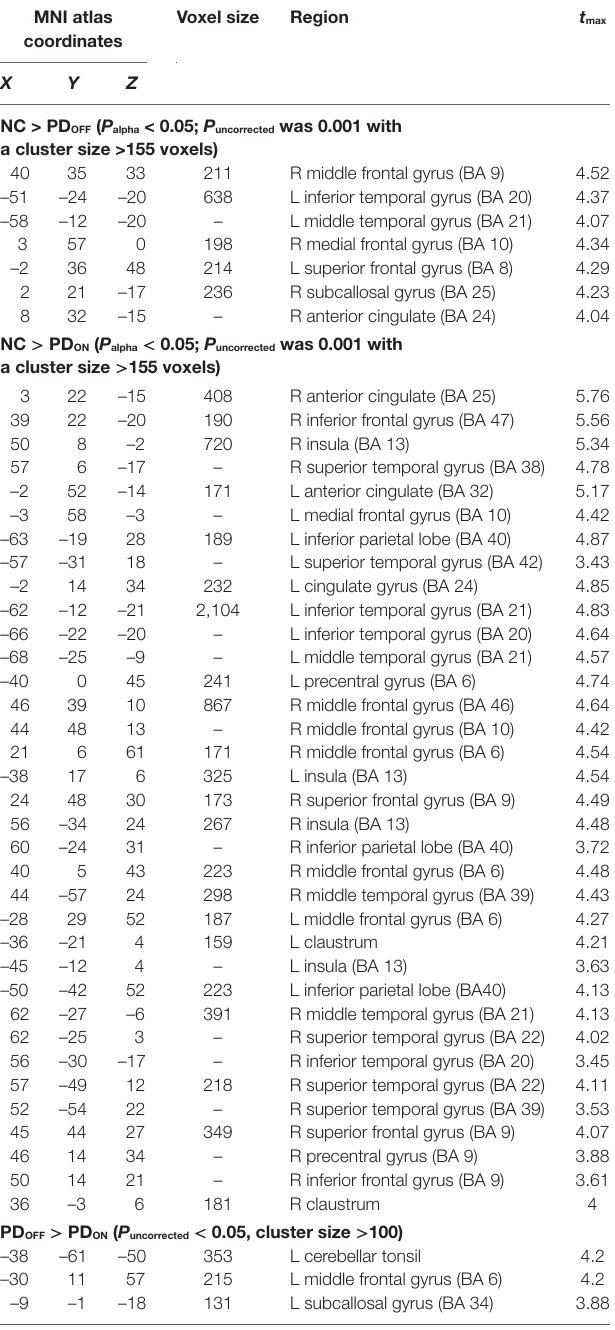
TaBle 2 | Comparisons of cerebral blood flow levels in different brain regions between NCs and patients in the ON or OFF states. Mni atlas